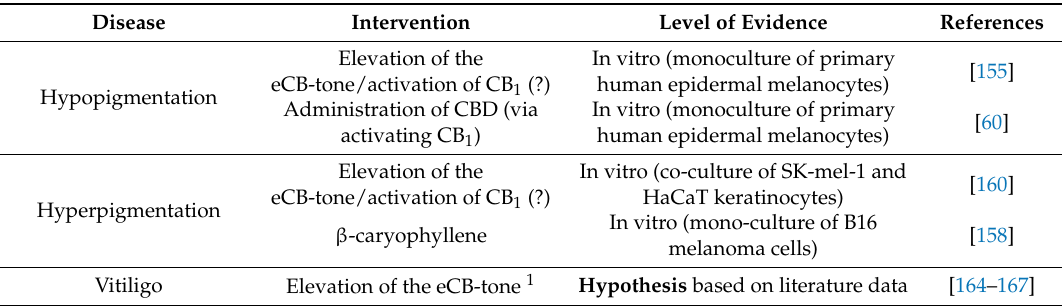
Overview of the putative pigmentation-relevant therapeutic potential of cutaneous cannabinoid